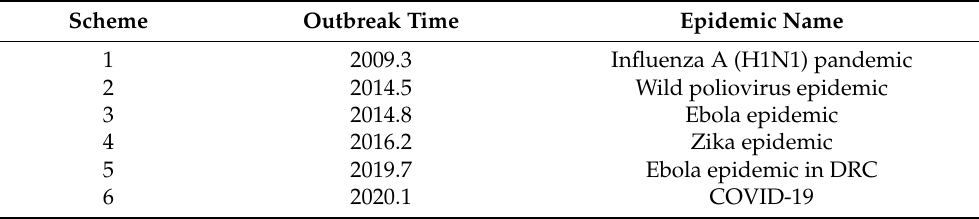
Table 1. Major infectious disease outbreaks classified as PHEIC by the WHO since 2007. Scheme Outbreak